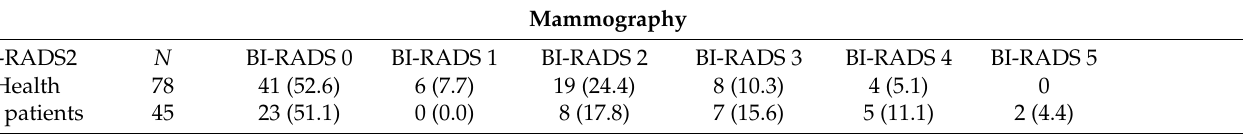
Table 4. Combined analysis of circulating methylated biomarkers, mammography and